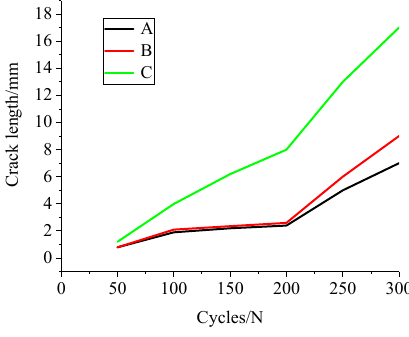
Figure 2. Thermal cycle times—average crack length curve.